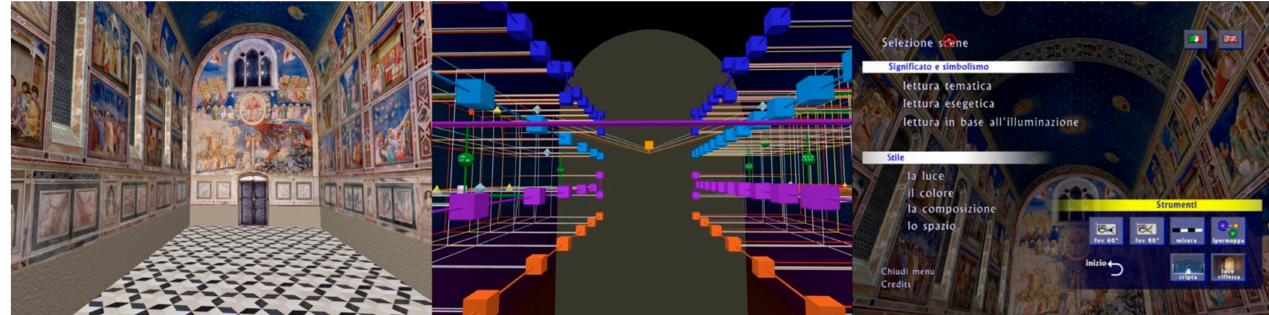
Figure 1. Scrovegni Chapel: Virtual reality application. ( Left ) the iconographic space reproducted in 3D. ( Center ) the cybermap, where each box represents a scene, and the informative network corresponds to thematic layers. ( Right ) the main menu allowing tematich layers to be activated CNR Institute of Technologies Applied to the Cultural Heritage